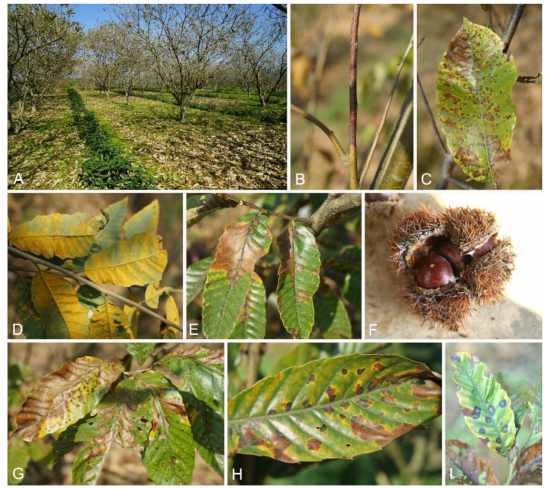
Figure 1. Field Sampling. ( A ) A Castanea plantation; ( B ) Symptoms of twig canker; ( C – E , G – I ) Symptoms of leaf diseases; ( F )